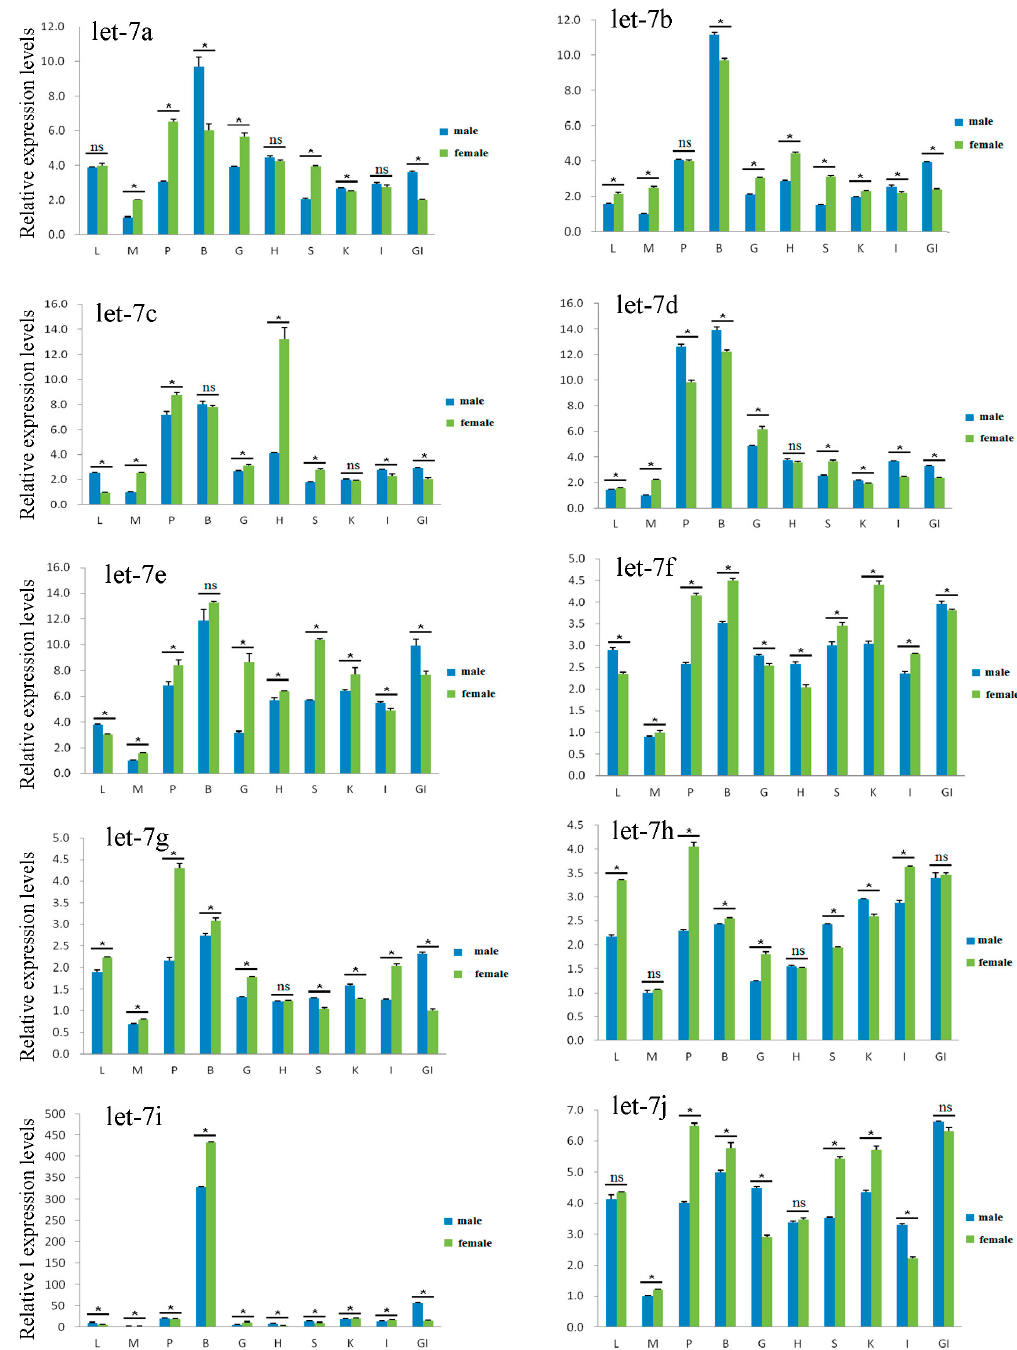
Figure 5. Let-7 miRNAs expression in ten tissues of 24-month-old M. amblycephala . L, liver; M, muscle; P, pituitary; B, brain; G, gonad; H, heart; S, spleen; K, kidney; I, intestines; GI, gill. Statistical significance between females and males is indicated as follows: * p < 0.05; ns, not significant.